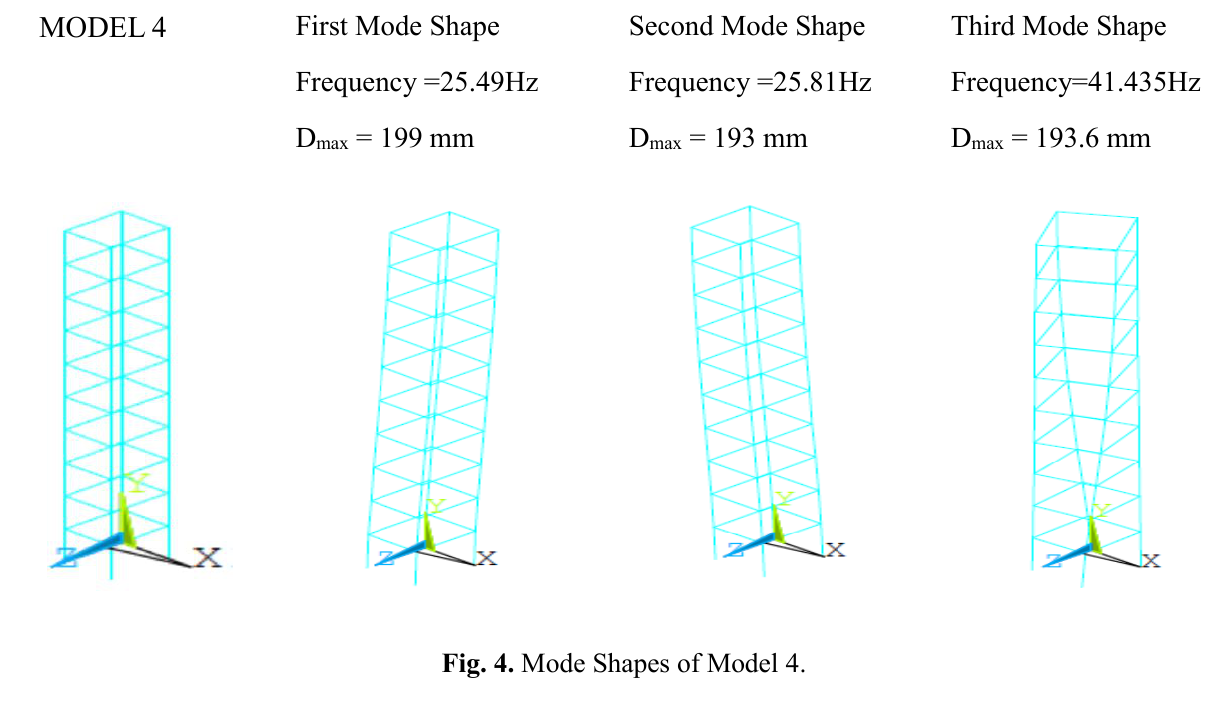
Fig. 4. Mode Shapes of Model 4.